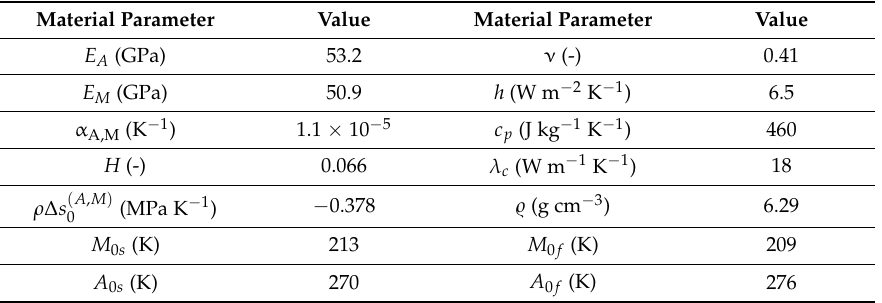
Table 1. TiNi SMA mechanical parameters used for thermo-mechanical numerical analysis. Material parameter